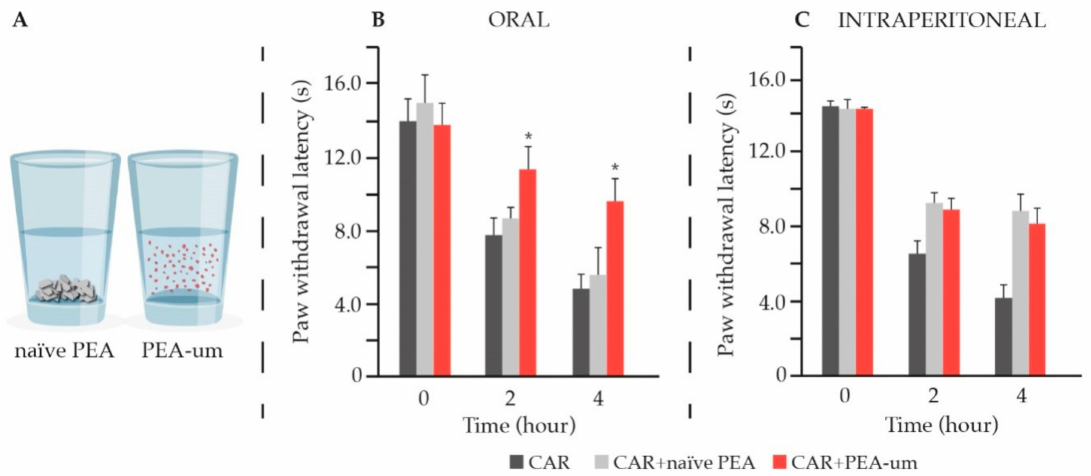
Figure 4. Advantages of PEA micronization. Reducing particle size increases particle surface area, resulting in higher dissolution rate of micronized PEA compared to the naïve form ( A ). In the carrageenan-induced hyperalgesia (CAR) PEA-um exerted a superior anti-hyperalgesic effect compared to naïve PEA after oral administration ( B ). On the contrary, no difference was observed after intraperitoneal administration ( C ). * p < 0.01 vs. CAR. Modified from